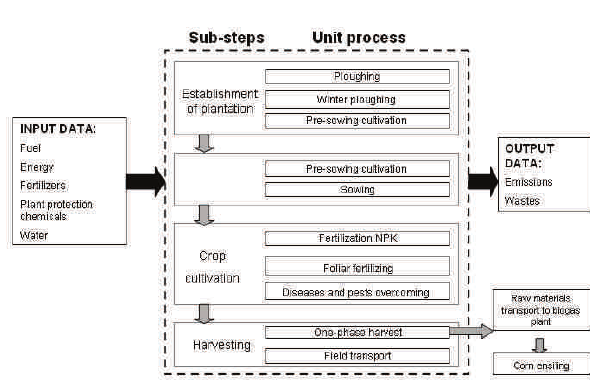
Fig. 1. The general scheme taking into account the system boundaries and functional unit of corn cultivation process and the silage formation